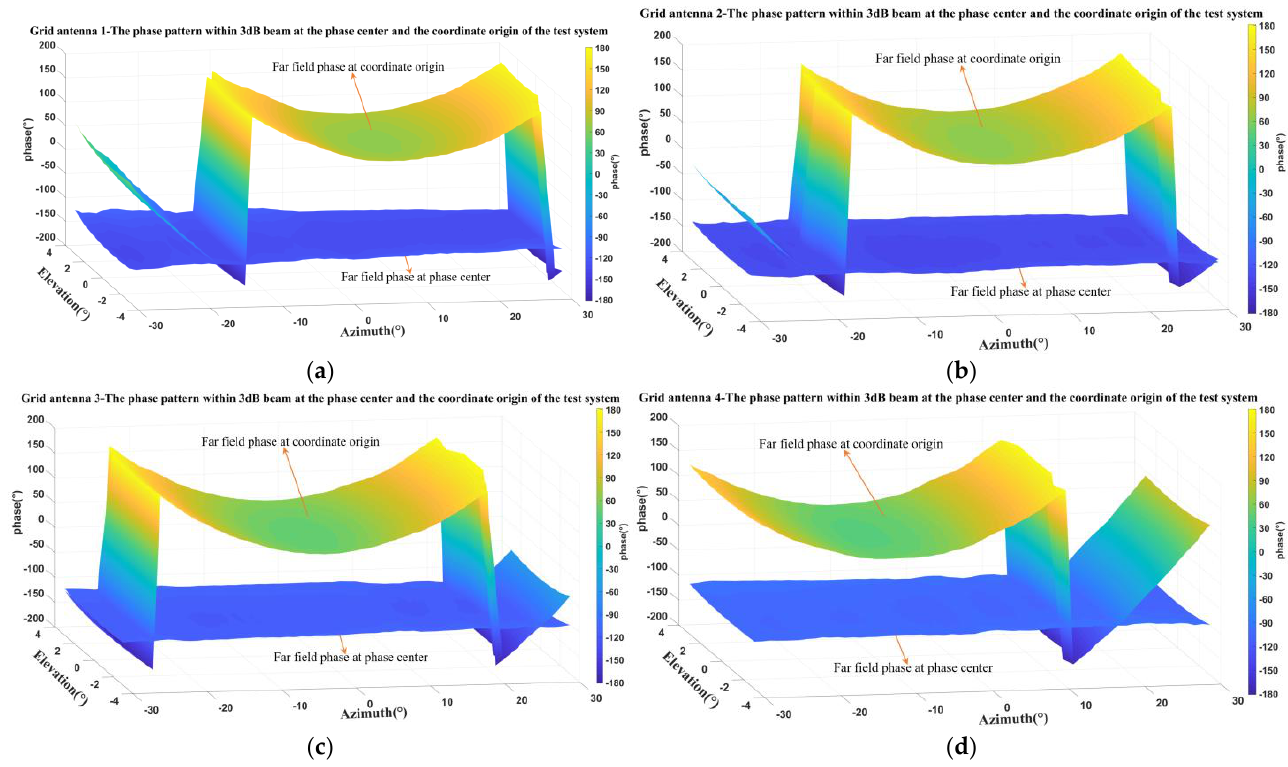
Figure 26. Measured far-field phase patterns at the coordinate origin and the phase center of every antenna element within the 3-dB beamwidth in sparse array: ( a ) grid antenna 1; ( b ) grid antenna 2; ( c ) grid antenna 3; ( d ) grid antenna 4.